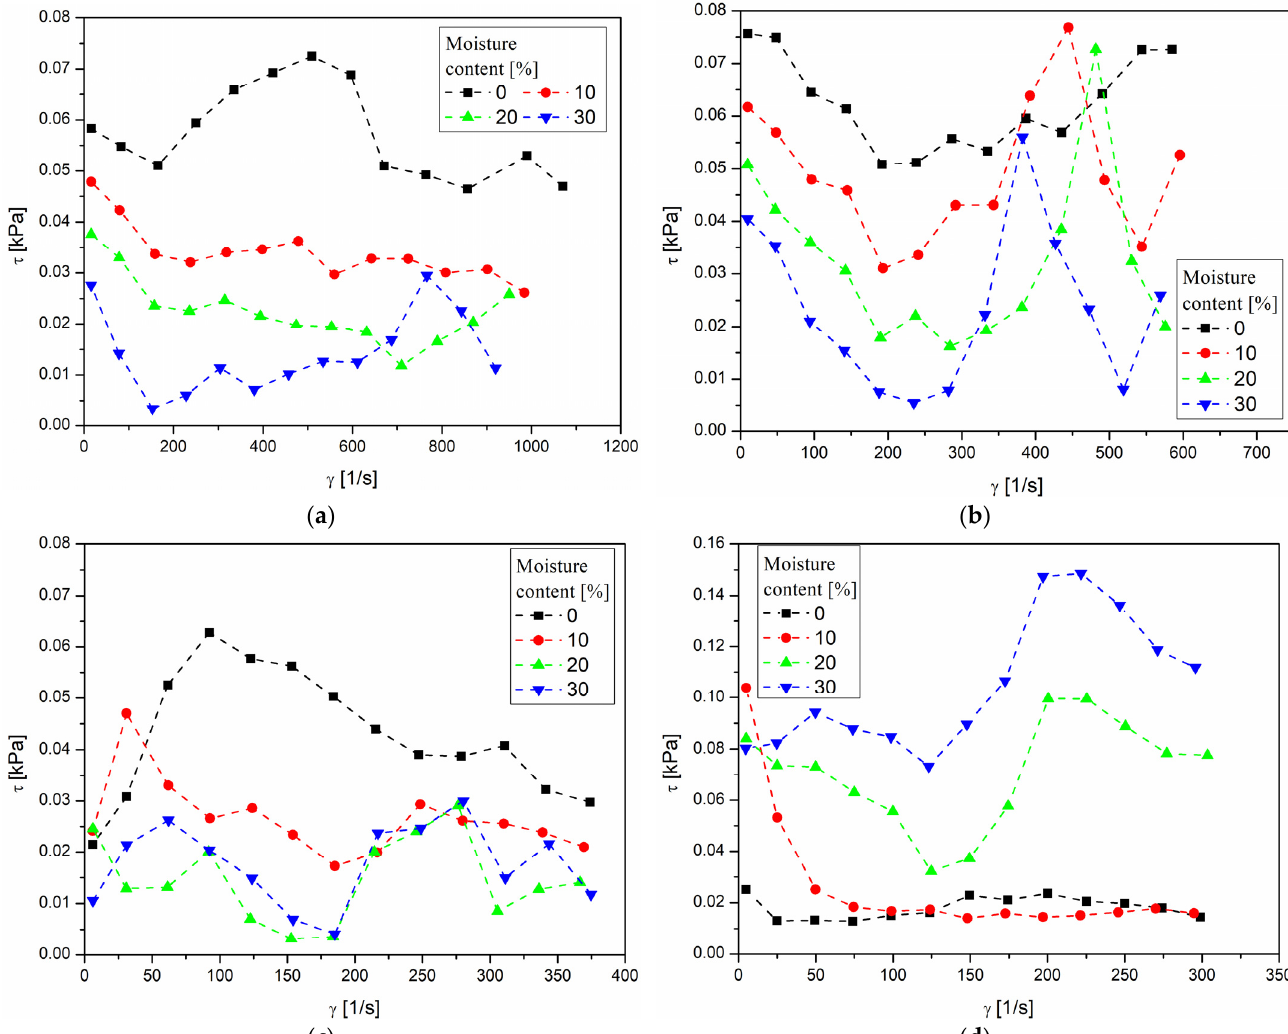
Figure 10. The influence of moisture content and shear rate γ ̇ on shear stress τ for: ( a ) mixture of HC 95%, DDGS 5%; ( b ) mixture of HC 70%, DDGS 30%; ( c ) mixture of HC 40%, DDGS 60%; ( d ) DDGS.